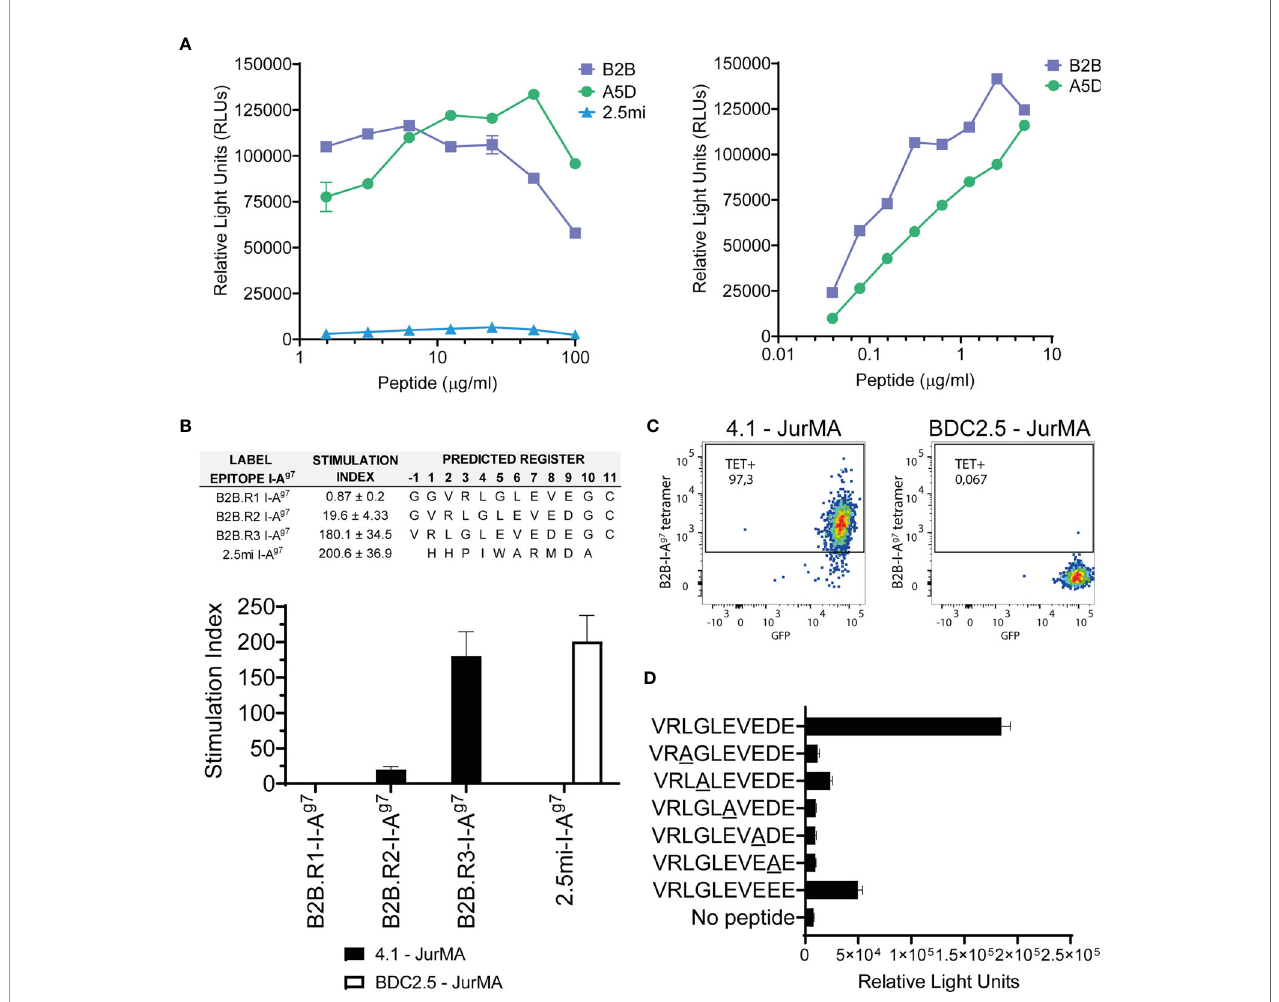
FIGURE 3 | De fi nition of the agonistic B2B I-A g7 -binding register. (A) 4.1-JurMA cells were co-cultured with HEK-293-I-A g7 cells and increasing concentrations of B2B, A5D, or BDC2.5mi peptides, and agonistic activity reported as RLUs. Left, 1 – 100 m g/ml range. Right, 0.01 – 10 m g/ml range. (B) Agonistic activity of three different plate-bound recombinant B2B-linker-I-A g7 pMHCIIs in which the B2B sequence was forced to bind to I-A g7 on three different registers via cys-trapping. Top, epitope sequences and absolute stimulation index values. Bottom, histogram plots. Data show that activation of 4.1-JurMA occurs preferentially via register